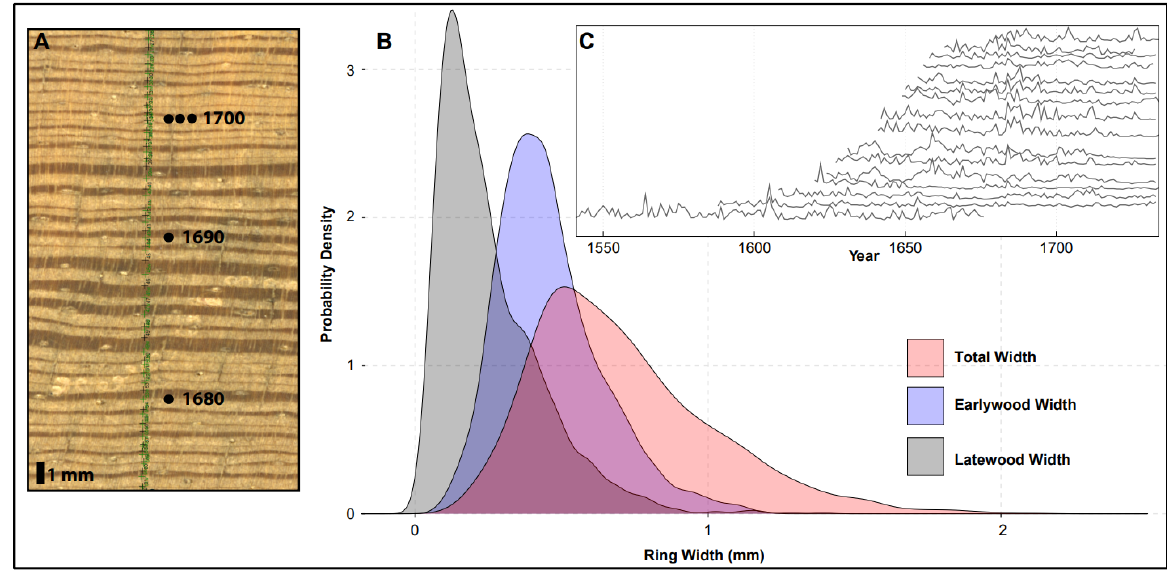
Figure 3. Walker House Pinus spp. ring-width measurement differences. ( A ) Scanned image example of sample DK3 showing measurement path (black and green +), decadal dates, and visual differences in total width, earlywood, and latewood width variability. ( B ) Probability density functions of all total width, earlywood, and latewood widths ( n = 1552) measured in Pinus spp. samples extracted from Walker House timbers. ( C ) Spaghetti plot of latewood widths from the 16 Walker House Pinus spp. samples.